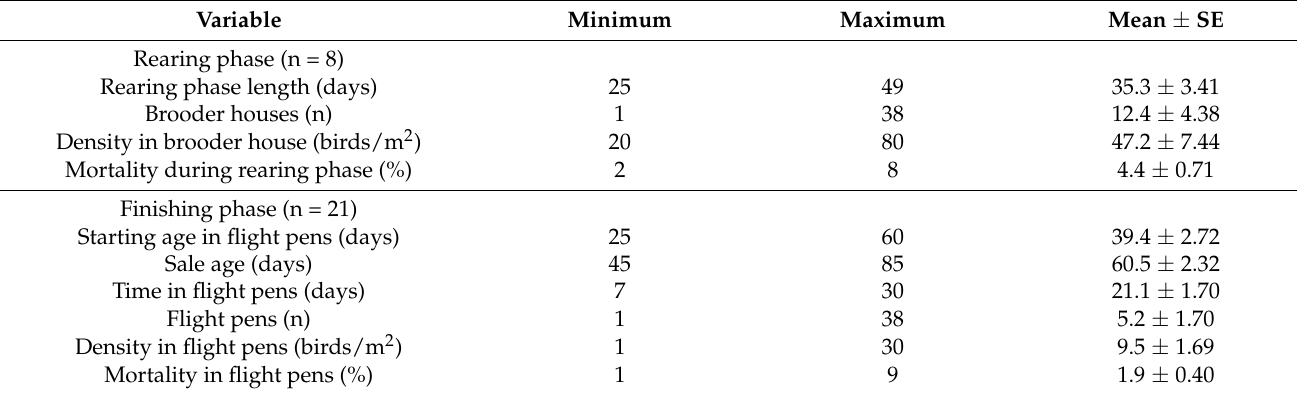
Table 3. Variables related to facilities and management during the rearing and finishing phases of quail game farming (n = 21).